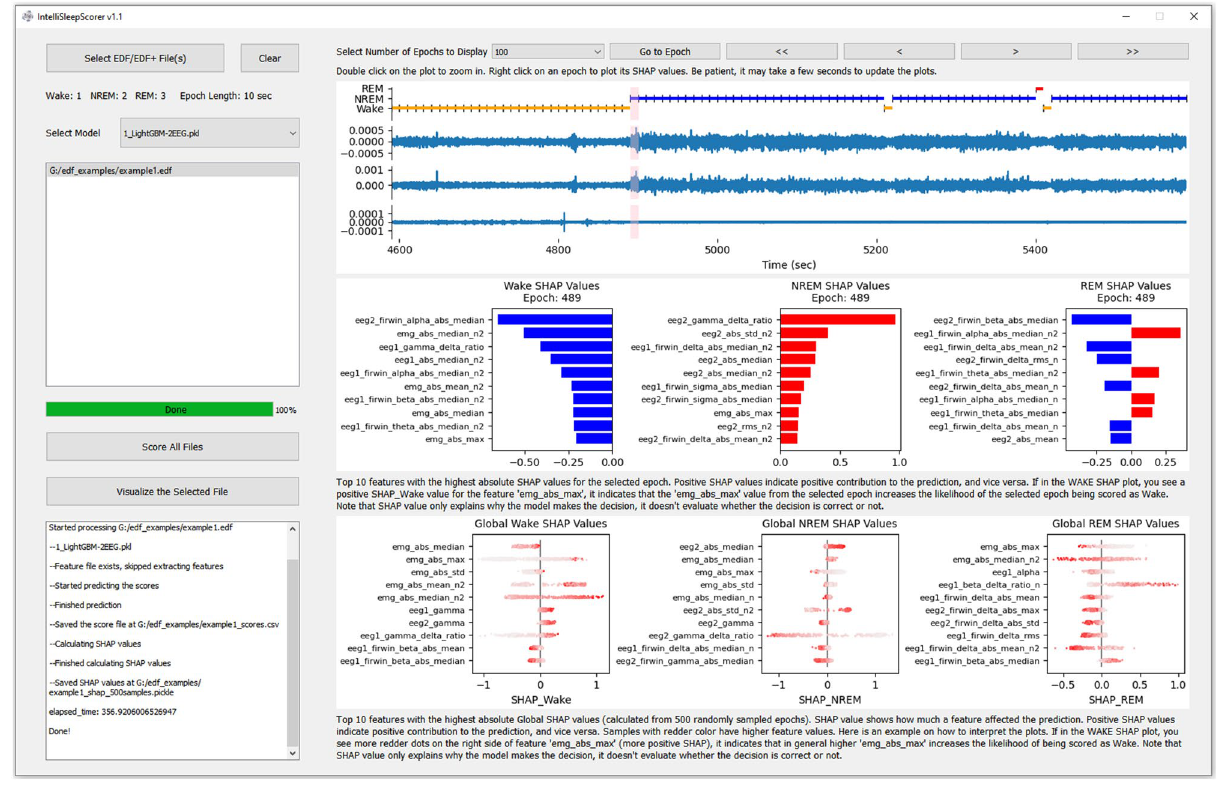
Figure 8. The GUI of IntelliSleepScorer. Please view the detailed documentation and instructions at https:// github. com/ broad insti tute/ Intel liSle epSco